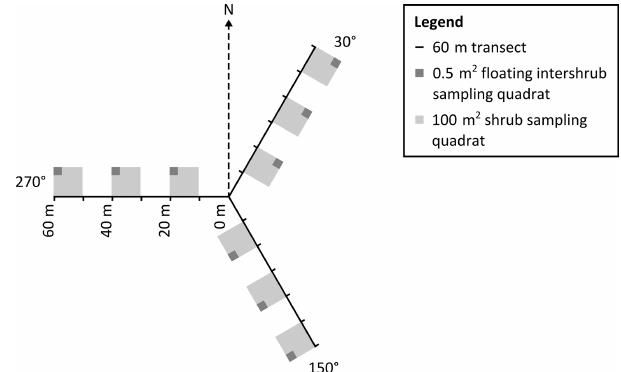
Figure 3. Plan view of sampling design in which grass and shrub biomass, as well as inter-shrub and shrub soil samples, were ob- tained from 0.5m 2 and 100m 2 quadrats, respectively (not to scale). The 0.5m 2 quadrats were not fixed but were instead centred within the largest inter-shrub area of each 100m 2